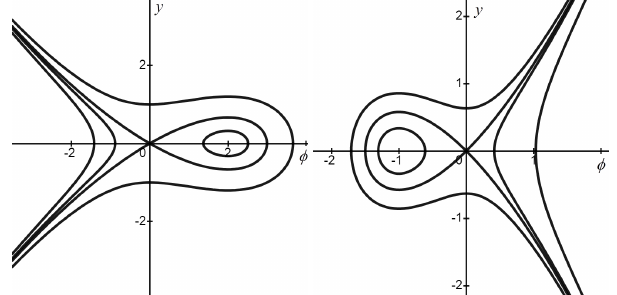
Figure 1. The phase portraits of the system (4) when ( v − 1 )( β + γ v ) >